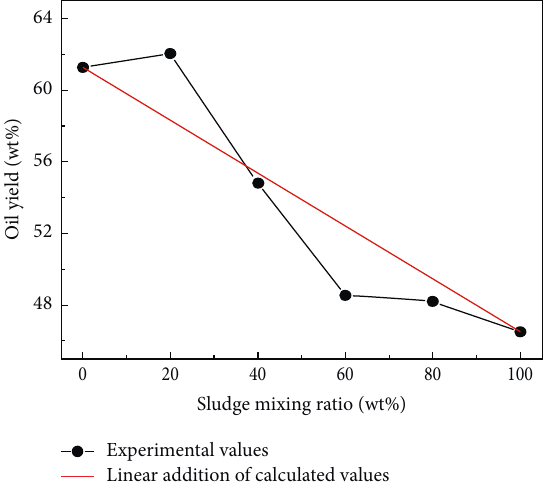
Figure 7: Variation curve of the oil production rate of pine sawdust and sludge copyrolysis with mixing ratio.